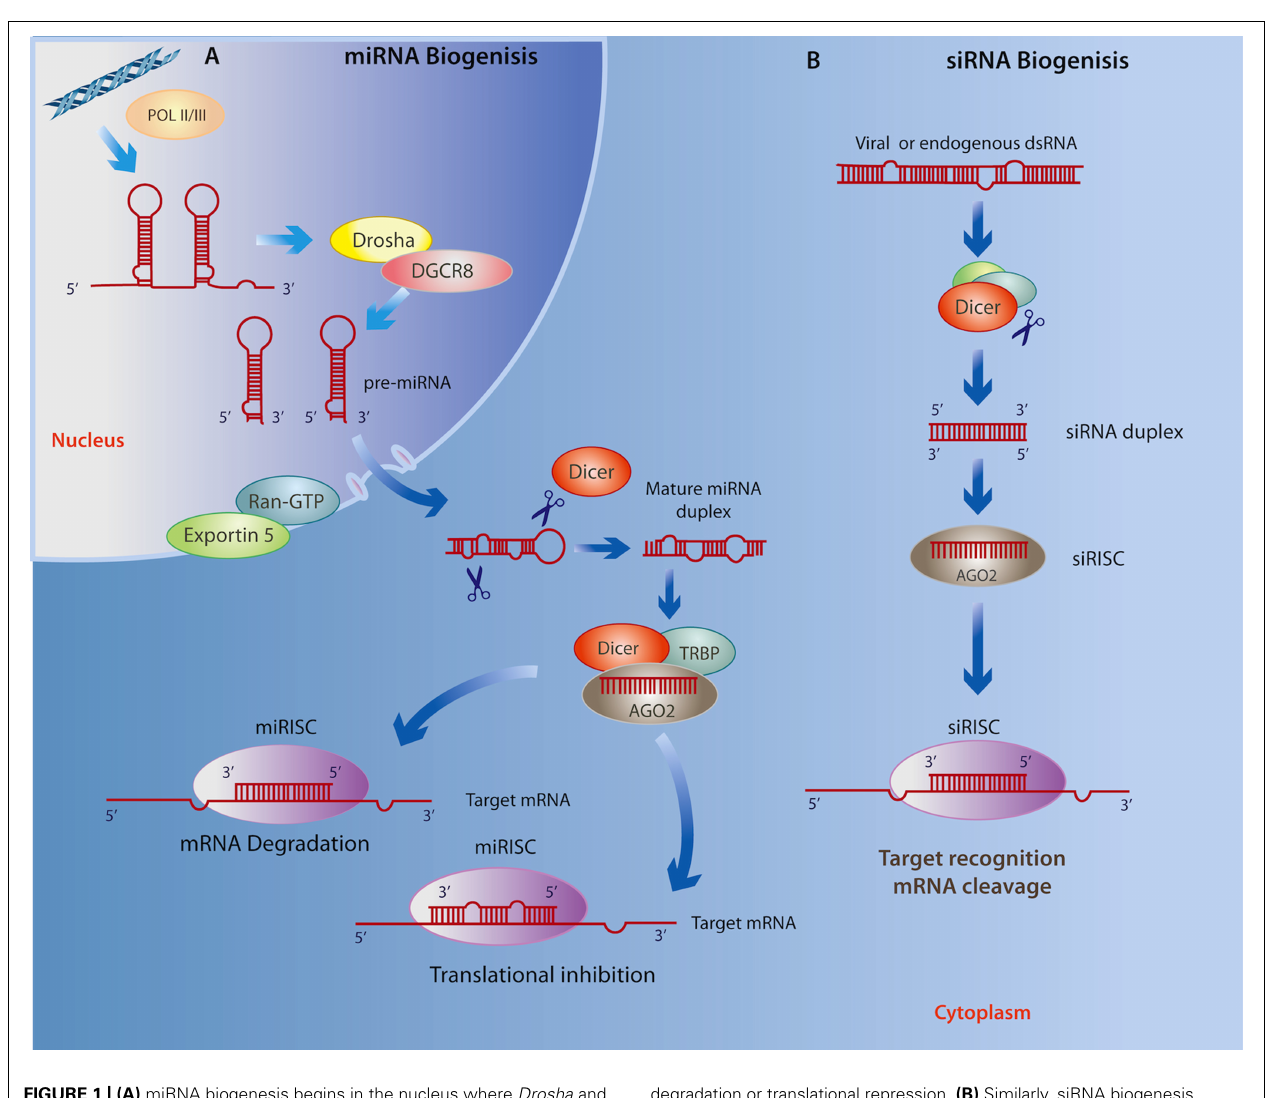
FIGURE 1 | (A) miRNA biogenesis begins in the nucleus where Drosha and DGCR8 cleave the primary RNA resulting in a miRNA precursor that is exported to the cytoplasm by Exportin5 and Ran-GTP61 where it is then processed by Dicer andTRBP. Next, the mature miRNA duplex is incorporated to the RISC where it is cleaved Dicer , associates with AGO2, and subsequently binds to the 3 (cid:3) UTR of a target RNA leading to either mRNA